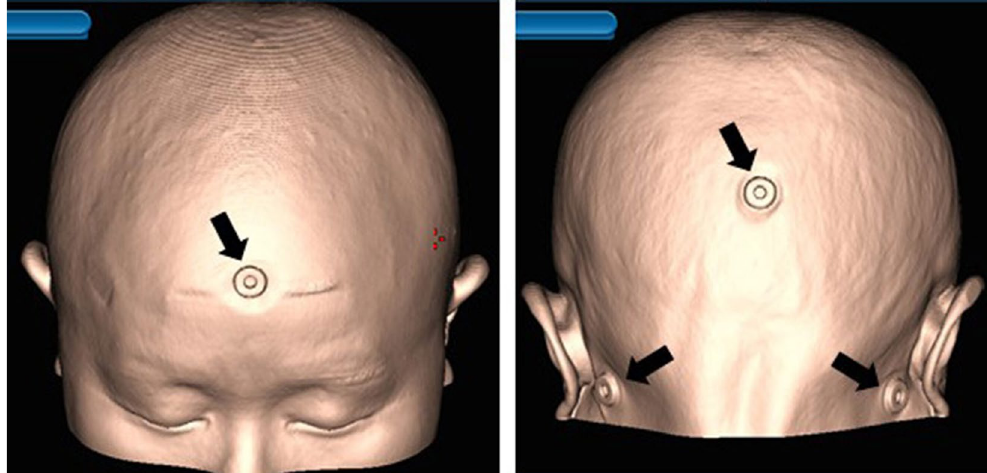
Figure 2. Fiducial markers were attached to the head as landmarks for the front, the back, the right, and left. A three-dimensional reconstruction using computed tomography shows that four fiducial markers (arrows) were implanted in the patient’s forehead (nasion), occipital region (inion), and bilateral retroauricle regions (mastoid